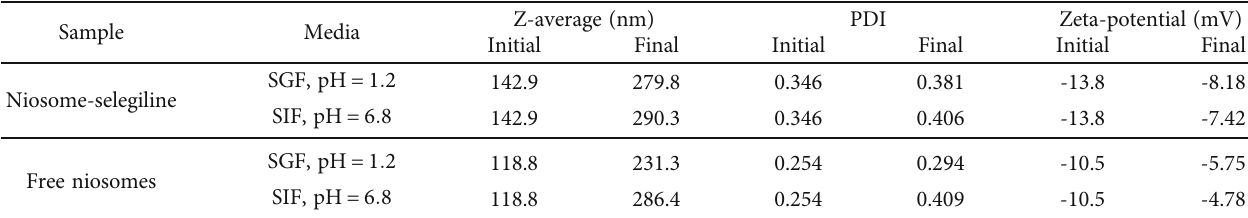
Figure 5: (a) Stability curves of niosomes and niosome-selegiline. (b) Rheological behavior of niosomes and niosome-selegiline at room temperature and atmospheric pressure. Table 3: DLS measurement of samples incubated in SGF and SIF